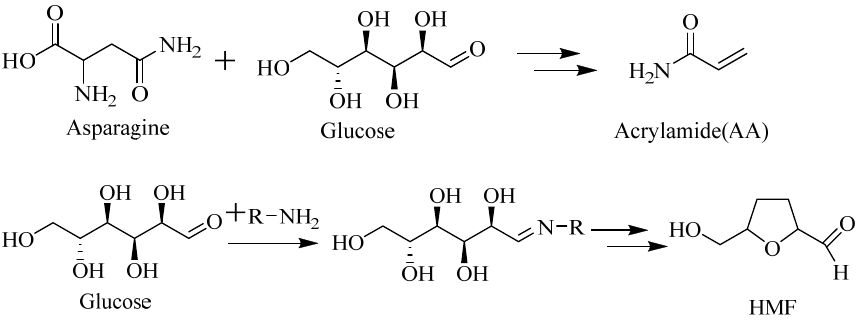
Figure 1. The formation of acrylamide (AA) and hydroxymethylfurfural (HMF).